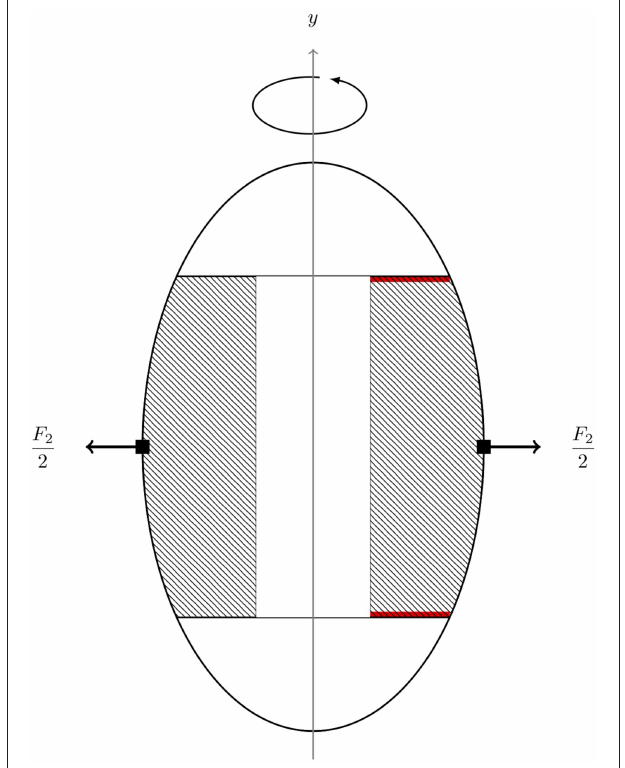
FIGURE 5 | Simplified sketch of cavity for clarification. Force acting on